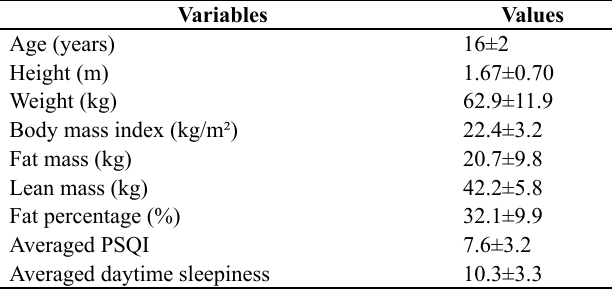
Table 1. General characteristics of the adolescents included in this